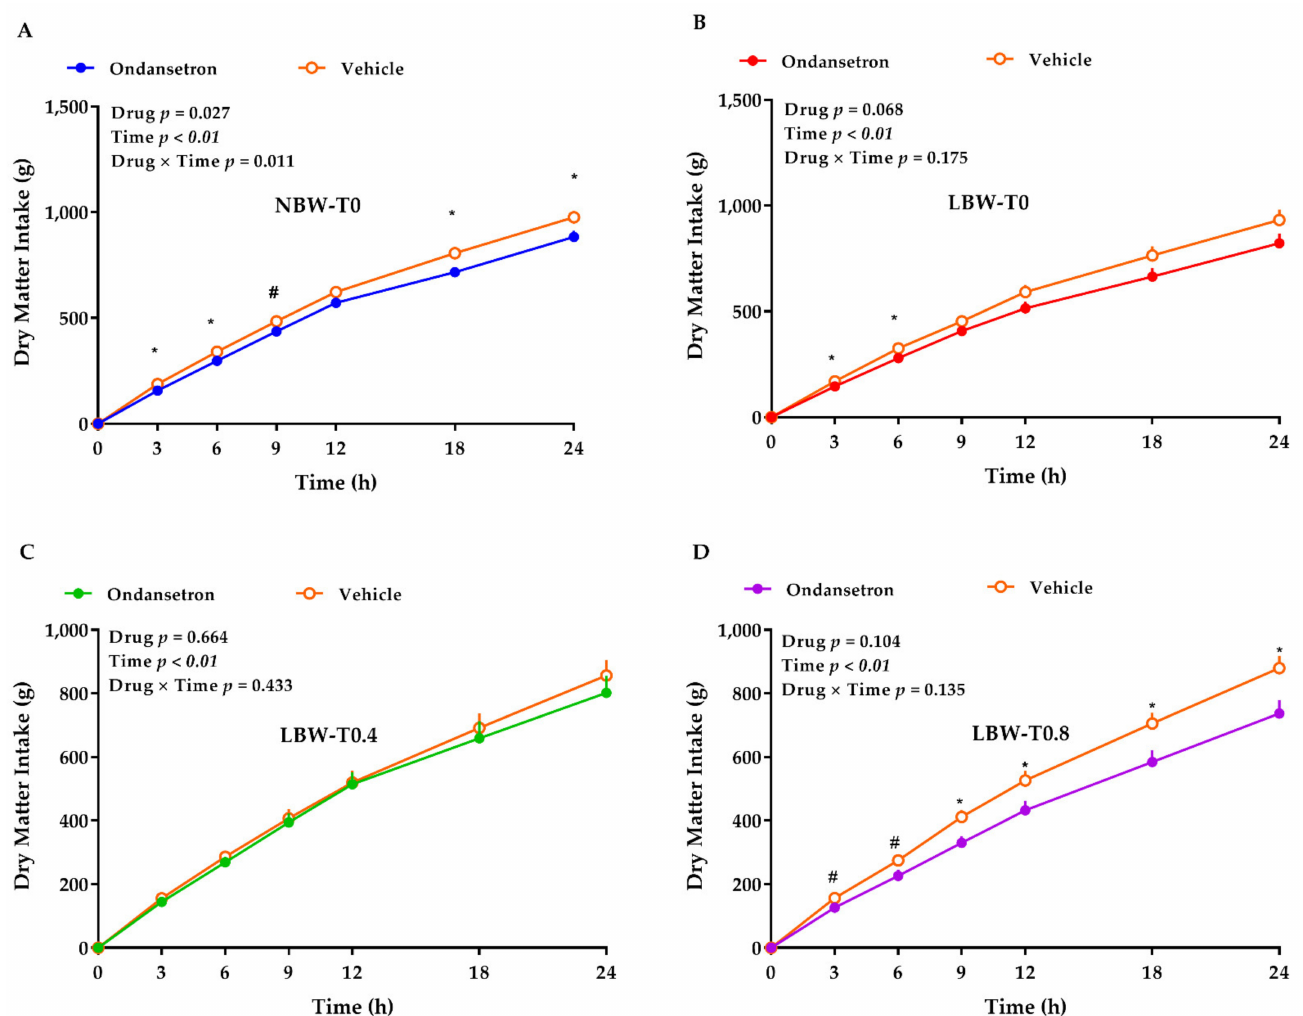
Figure 4. Effect of saline or ondansetron injection on the dry matter intake of low-birthweight neonatal pigs fed with milk-based diets supplemented with L-tryptophan. ( A ) NBW-T0, normal-birthweight piglets fed a basal diet without supple- mented L-tryptophan (Trp), ( B ) LBW-T0, low-birthweight piglets fed a basal diet without supplemented Trp, ( C ) LBW-T0.4, low-birthweight piglets fed a diet supplemented with 0.4% Trp, and ( D ) LBW-T0.8, low-birthweight piglets fed a diet supple- mented with 0.8% Trp. All pigs were injected either with saline or the drug (ondansetron, 200 µ g × kg − 1 , SC). The p values for the overall model effect for the drug, time, diet, drug × time, drug × diet, time × diet and drug × time × diet for dry matter intake were <0.01, <0.01, 0.083, <0.01, 0.470, 0.108, and 0.707, respectively. n = 8 for NBW-T0, LBW-T0, and LBW-T0.8, and n = 7 for LBW-T0.4. * p ≤ 0.05 saline vs. ondansetron within each diet; # 0.05 < p ≤ 0.1 saline vs. ondansetron within each diet. The values are the means ±